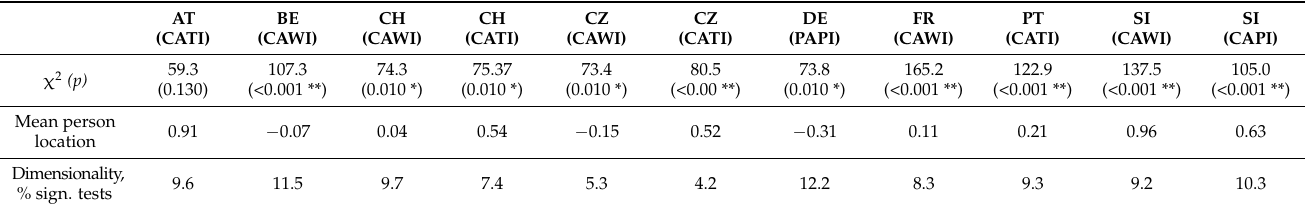
Table 6. Overall data–model fit for the polytomous HLS 19 -NAV data when fitted against the partial credit parametrization of the unidimensional Rasch model (taken from Guttersrud et al. [47] (p.